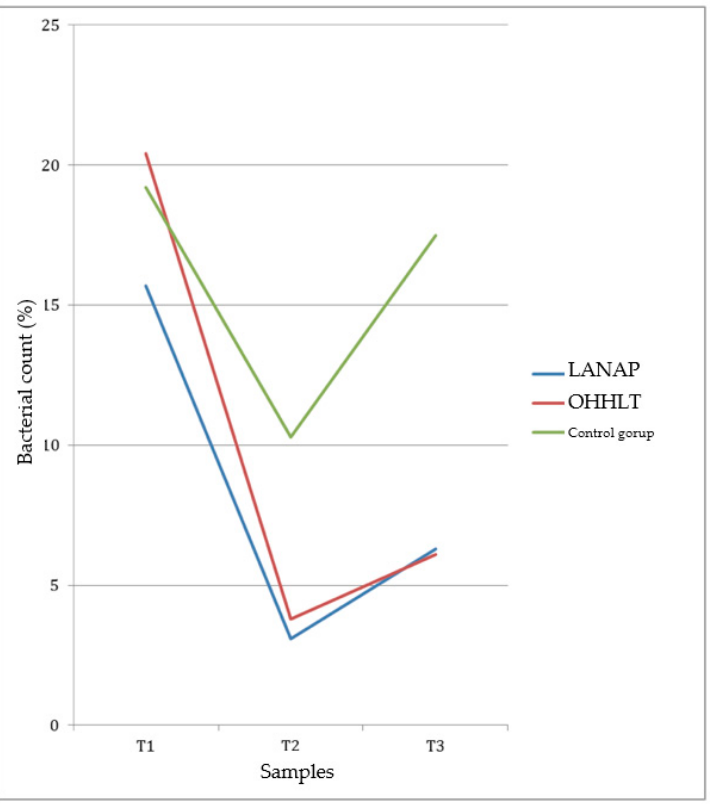
Figure 8. Microbiological results of the three groups at the three collection moments . Table 1. Periodontal and microbial parameters among the A + B groups and C group before treat- ment .